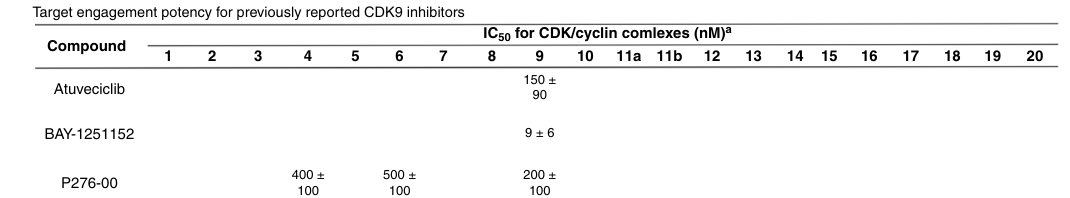
CDK1 − 6, and exhibited pan-TAIRE-family activity (CDK15 – 18), (Supplementary Fig. 18). In our cellular analysis, the